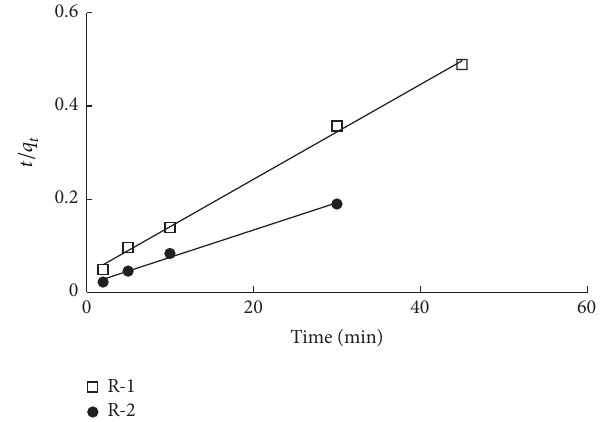
Figure 5: The pseudo-second-order kinetics